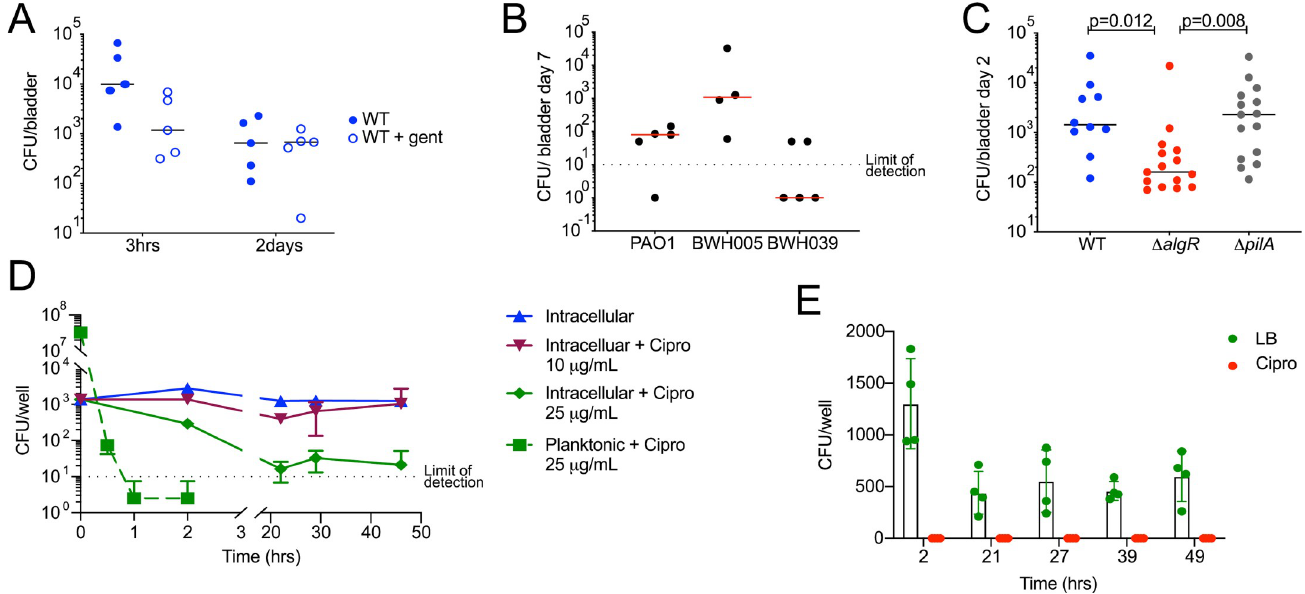
Fig 6. Bacterial intracellular survival increases in vivo persistence in a mouse model of urinary tract infection and decreases antibiotic efficacy. (A-C) C57BL/ 6 female mice were transurethrally inoculated with 1–6 x 10 7 CFU P . aeruginosa . (A) At 3 hours or 2 days post-infection, bladders were harvested and incubated for 30 minutes in media alone or gentamicin to kill extracellular bacteria; the entire bladder was then homogenized to determine total (untreated) and intracellular (gentamicin treated) bacterial load. n = 5 per time point per condition. (B) Mice were infected with the lab-adapted strain PAO1 or two clinical strains isolated from urine (BWH005 and BWH039). Seven days post-infection, bladders were harvested, homogenized and bacterial load was determined. n = 4 or 5 per strain. (C) Mice were infected with WT, Δ algR or Δ pilA PAO1 P . aeruginosa . Two days post-infection, bladders were harvested and homogenized to determine bacterial load. Adjusted P value of Dunn’s multiple comparisons test between groups displayed. n = 10–15 mice from 3 independent experiments. (D) Bladder epithelial cells were infected with WT bacteria for 2 hours and then incubated with gentamicin plus the cell permeable antibiotic ciprofloxacin at either 10 or 25 μ g/mL. At the indicated time points intracellular bacterial load was determined. For comparison, the same inoculum of bacteria was treated with 25 μ g/mL ciprofloxacin without host cells and the number of surviving bacteria was determined. (E) Cells were infected with WT bacteria and treated as in D with ciprofloxacin (10 μ g/mL) and the lysate was plated in the absence of presence of ciprofloxacin (10 μ g/mL). Minimum level of detection was 5